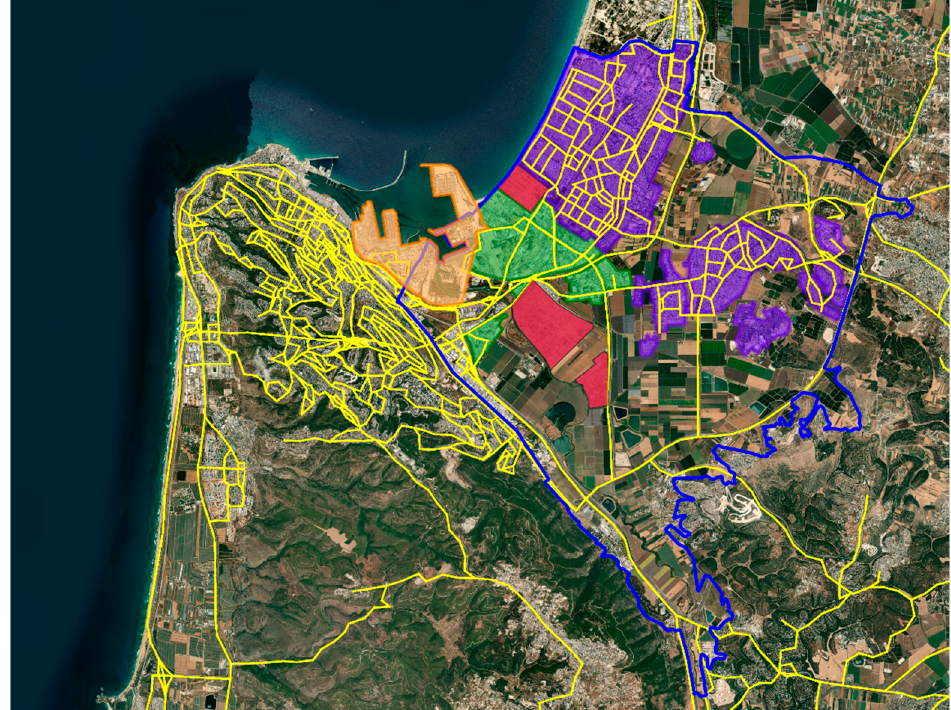
Figure 1. The Haifa Bay area (HBA). The blue border signifies the borders of southern Zevulun valley, which defines the Haifa Bay area. The colored polygons define various types of areas: major industrial facilities (red), light industry and employment areas (green), residential areas (purple), port (orange). Roads are marked by yellow lines.